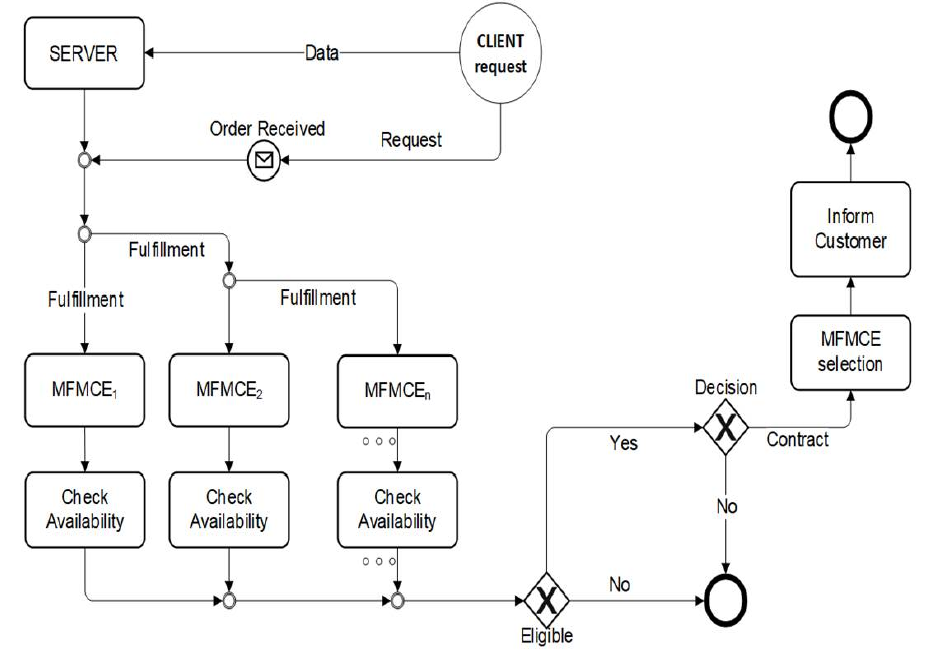
Figure 3. Production and distribution network partners selection algorithm.